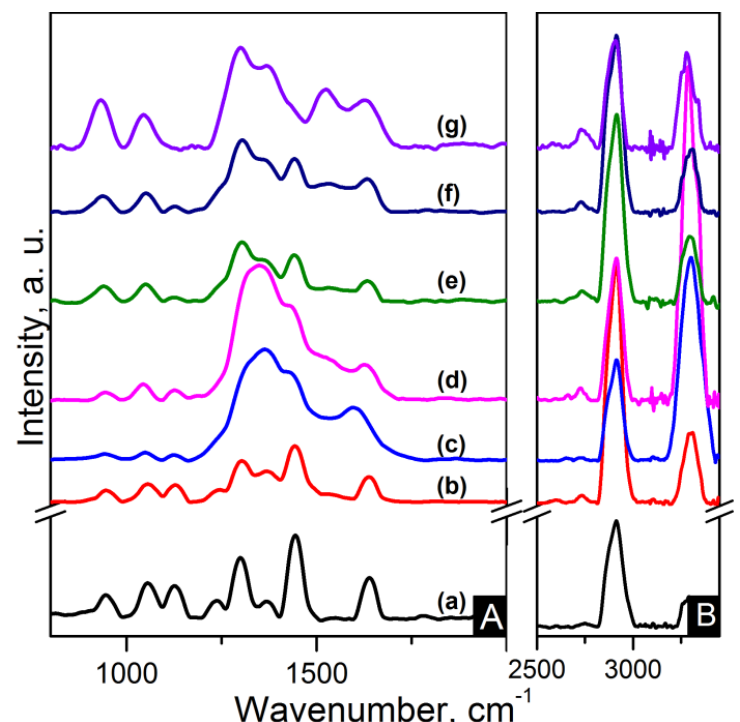
Figure 8. Raman spectra of the ( A ) 800–2000 cm − 1 region and ( B ) zoom-out of the 2800–3350 cm − 1 region of the samples: ( a ) pure PA66; ( b ) PA66/01RGO;